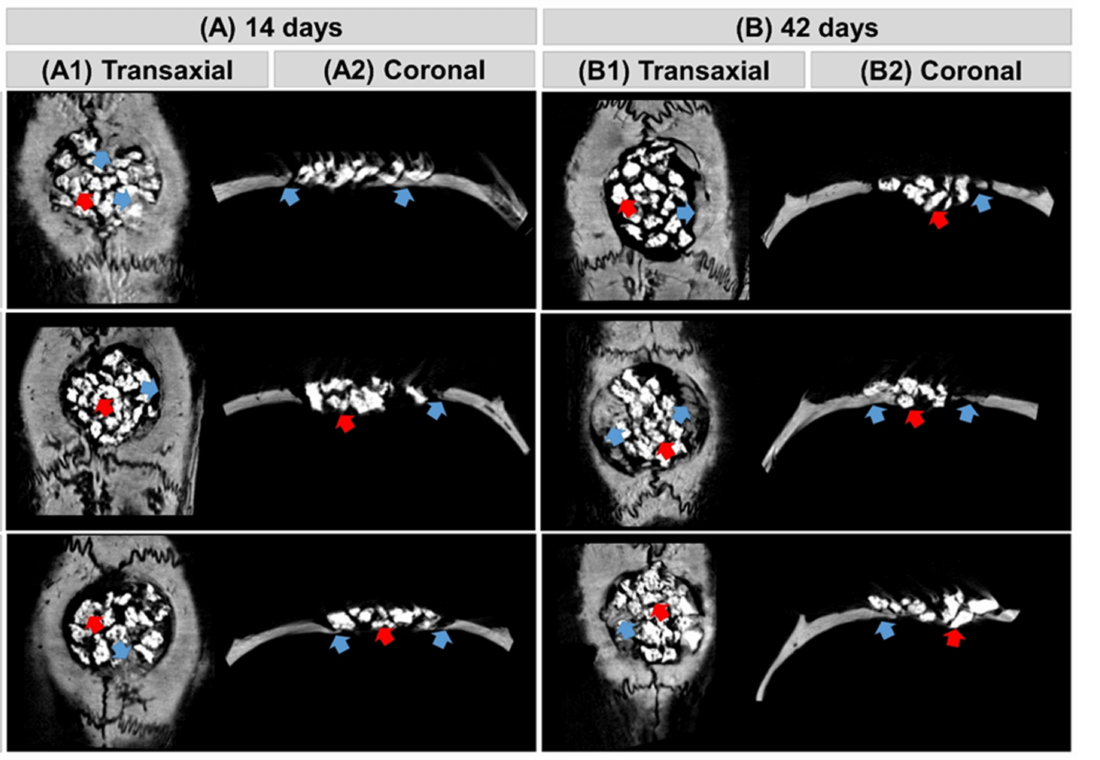
Figure 1. ( A , B ) Two-dimensional (2D) reconstructions of microtomographic images in transaxial ( A1 , B1 ) and coronal ( A2 , B2 ) sections of bone defects in the calvary of rats at 14 and 42 days, respectively. BMG—defects filled with biomaterial and covered by a membrane; BFMG—defects filled with the association of biomaterial and fibrin biopolymer, covered by a membrane; BFMLG—defects filled with the association of biomaterial and fibrin biopolymer, covered by a membrane and photobiomodulation therapy (PBMT). Blue arrow—new bone tissue; red arrow—particle of